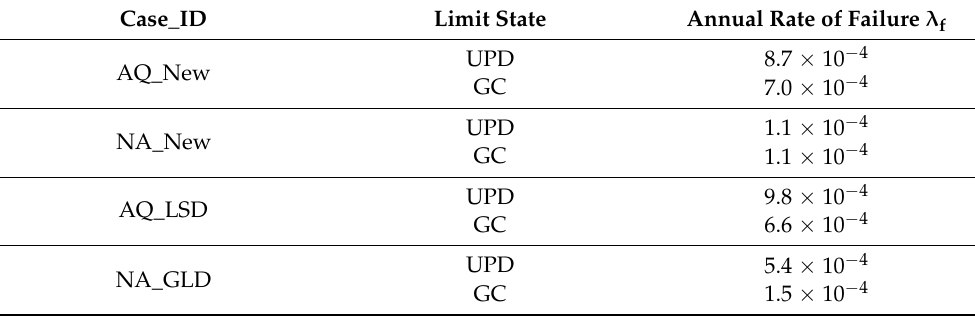
Table 6. Annual rates of failure for the analysed